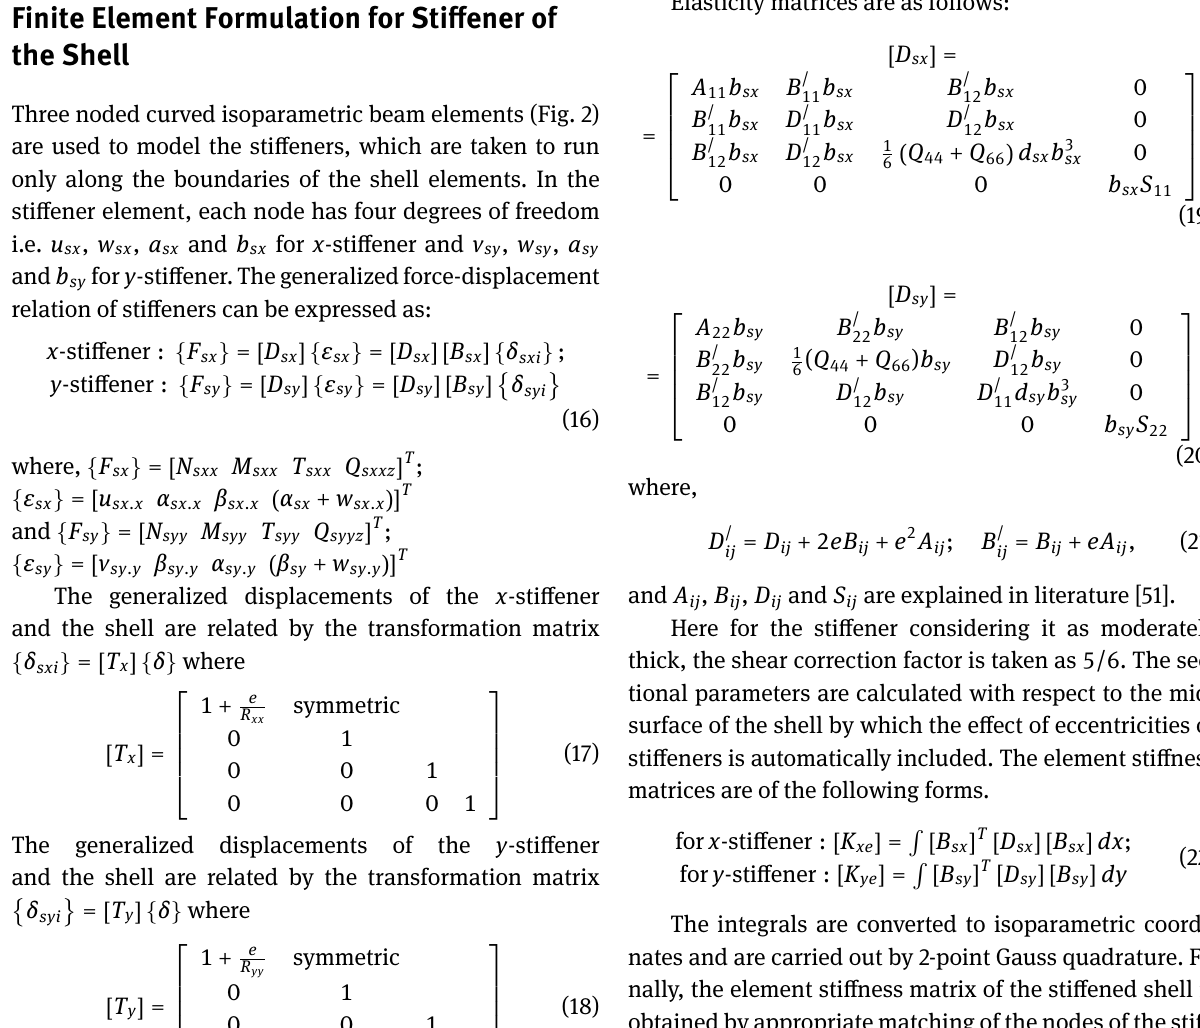
These transformations are required due to curvature of x -stiffener and y -stiffener. In the above equations, e is the eccentricity of the stiffeners. { δ } is the appropriate portion of the displacement vector of the shell excluding the dis- placement component along the other